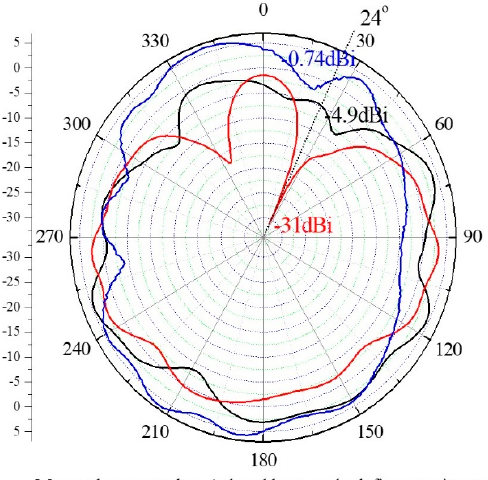
Figure 9. Characterization results of beam patterns radiated from WAVE antenna with/without